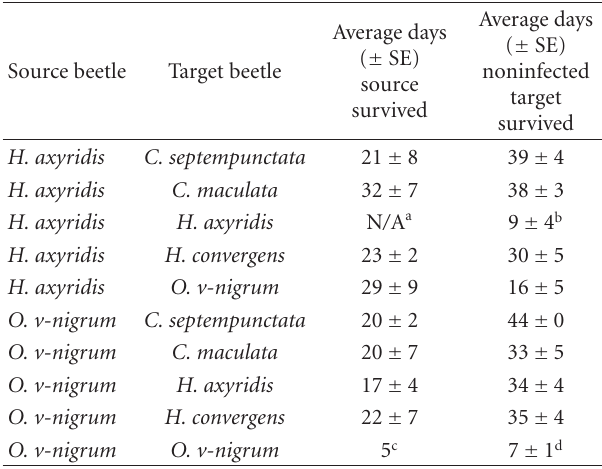
Table 3: Average days ( ± SE) that H. virescens source lady beetles and target lady beetles (that were not infected during the experi- ment) survived when one source lady beetle and three target lady beetles were housed together in Petri dishes for 44